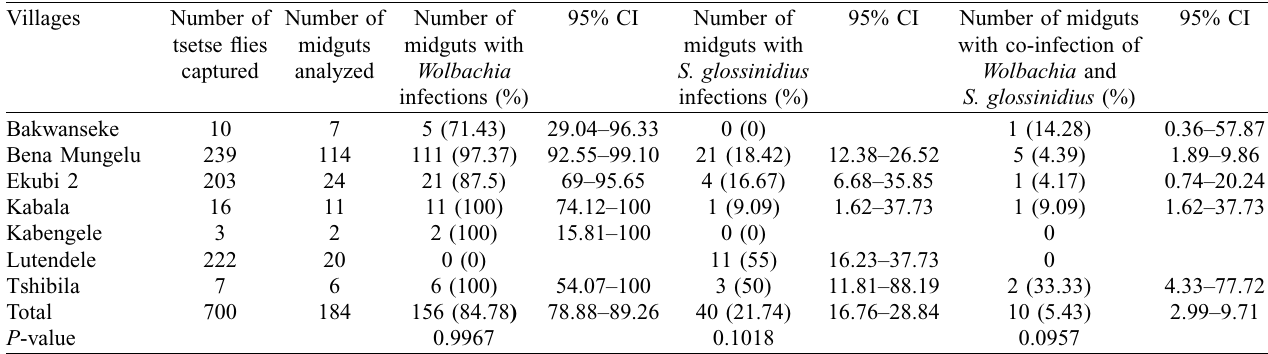
Table 3. Wolbachia and S. glossinidius infection rates according to villages and number of tsetse with co-infections of Wolbachia and S. glossinidius.